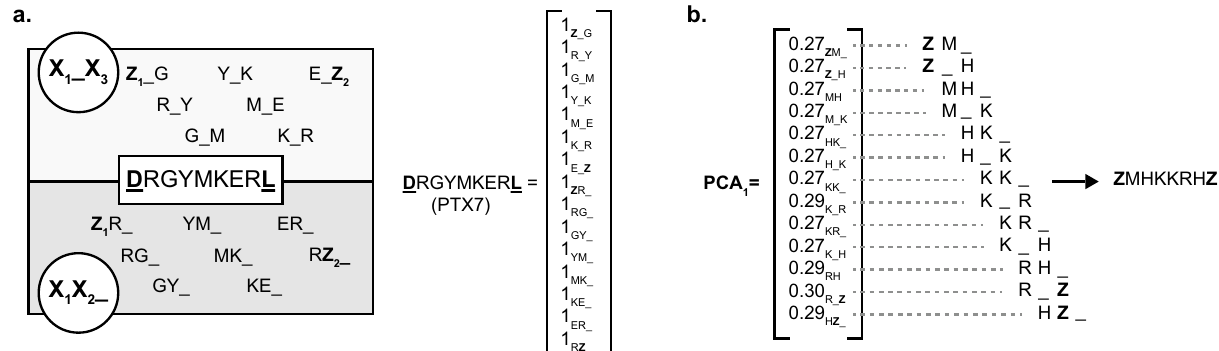
Figure 4. K -mer sequence decomposition and reconstruction. ( a ) Sequences can be decomposed into all possible masked 3-mers (i.e. X 1 X 2 X 3 separated into X 1 X 2 _ and X 1 _X 3 ) as shown for PTX7. Each masked 3-mer is counted generating an 882-dimension vector (non-zero elements shown). Vectors are normalized (divided by √ 15 in the case of PTX7) and multiplied by their enrichment score. Principal component analysis (PCA) identifies enriched k -mers, which allow a sequence to be reconstructed. An arbitrary cut-off (0.1) can be used to minimize noise and facilitate assembly. ( b ) The sequence reconstruction of the first PCA component calculated from the second library